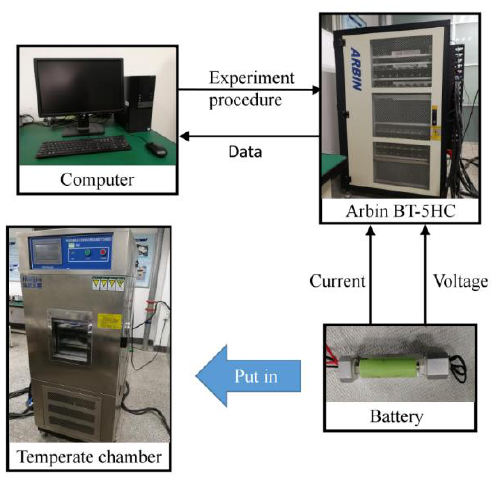
Figure 3. The test bench for battery.